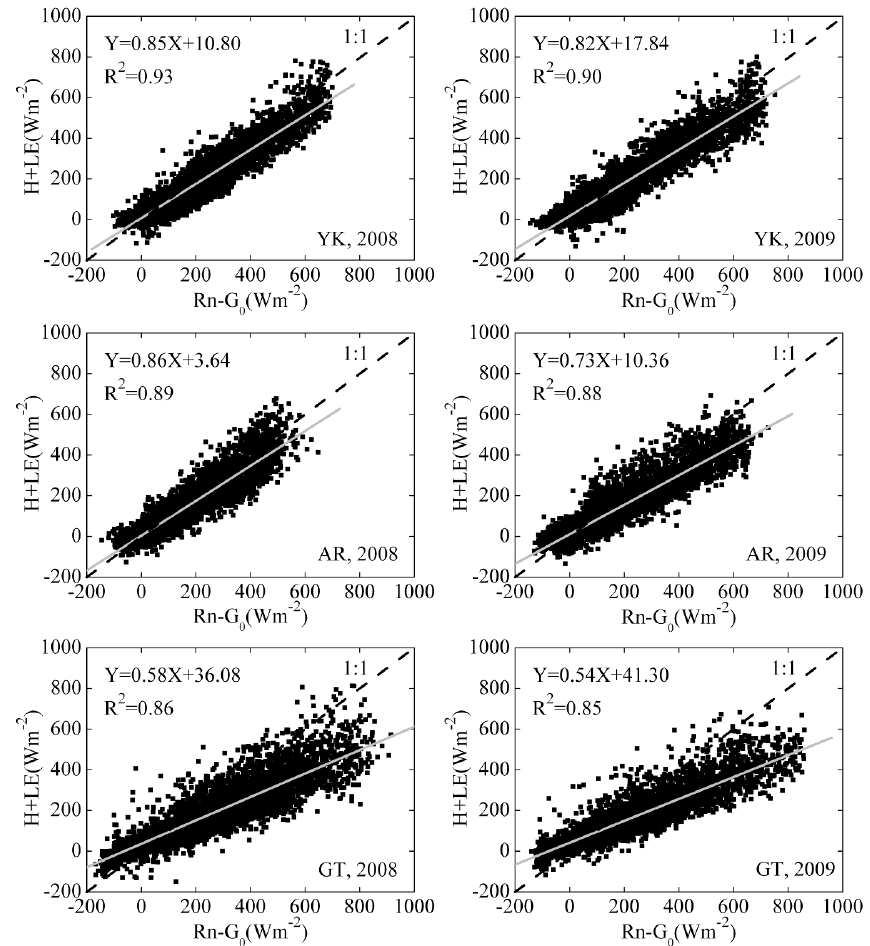
Fig. 4. Relationship between the available energy and the sum of the turbulent energy fluxes based on 30-min EC data at YK, AR and GT in 2008 and 2009